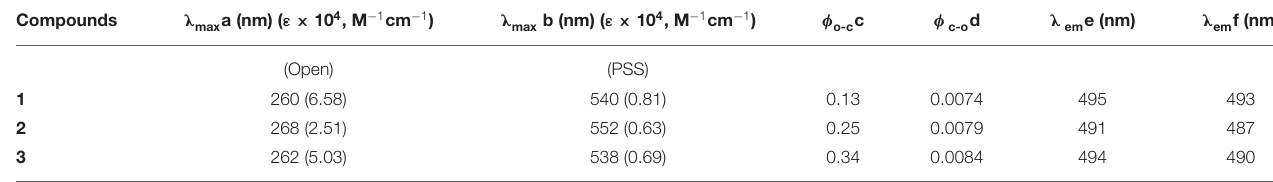
TABLE 1 | Photochromic parameters of dithienylethenes 1 – 3 in THF (2 × 10 − 5 M) and emission data in the aggregated and powder states.